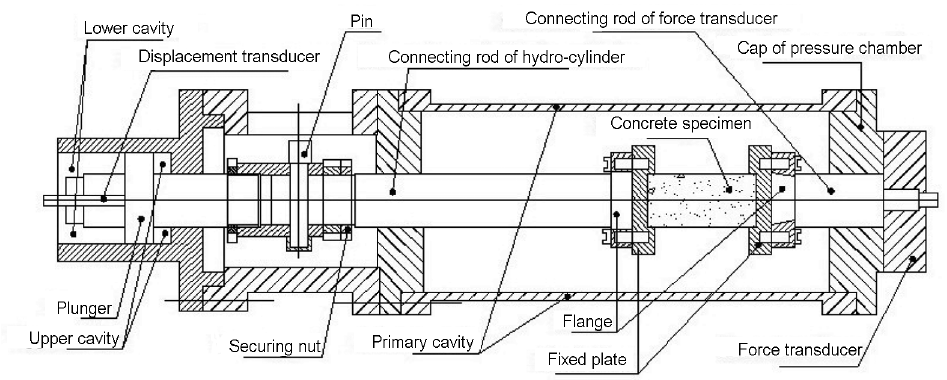
Fig. 4. Interior structure of the